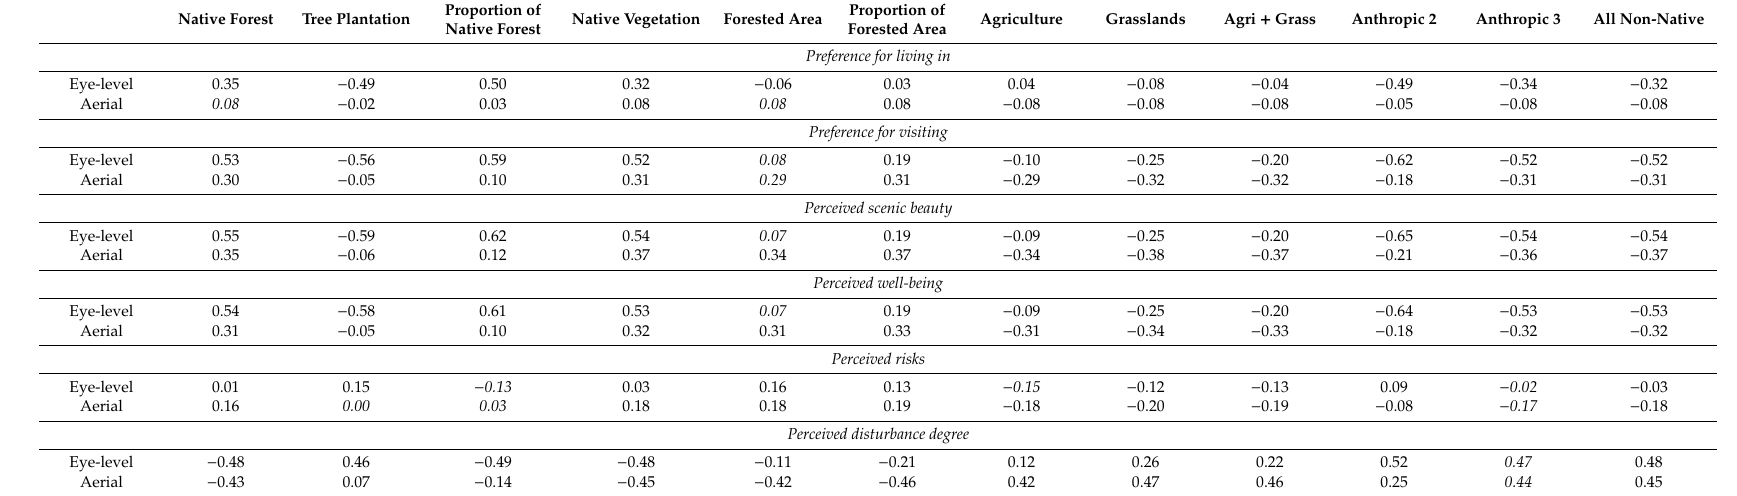
Table A3. Pearson correlation coe ffi cients between land-use types (% cover) and preference values obtained using eye-level and aerial images. All coe ffi cients were significant at p < 0.05, except those in